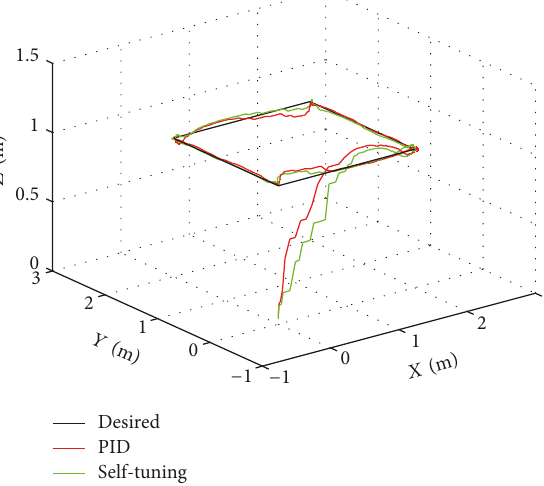
Figure 15: Three-dimensional response curves of quadrotor UAV position (𝑥,𝑦, 𝑧)